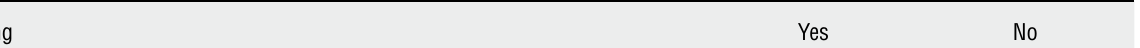
Cutting Exceeded task time limit Lower than the max portion of cloth cut More than the minimal portion of cloth cut Complete pattern cut not completed Did cloth come loose from clips? Percentage cutting out of boundary area with right hand exceeded Percentage cutting out of boundary area with left hand exceeded Greatest distance out of cutting boundary with left hand exceeded Greatest distance out of cutting boundary with right hand exceeded Number of unsuccessful cutting attempts with left hand exceeded Number of unsuccessful cutting attempts with right hand exceeded Virtual aid usage